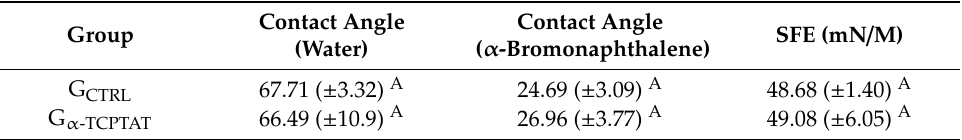
Table 2. Mean and standard deviation values of contact angle with distilled water and α -bromonaphthalene and surface free energy (SFE) of experimental sealant resins.